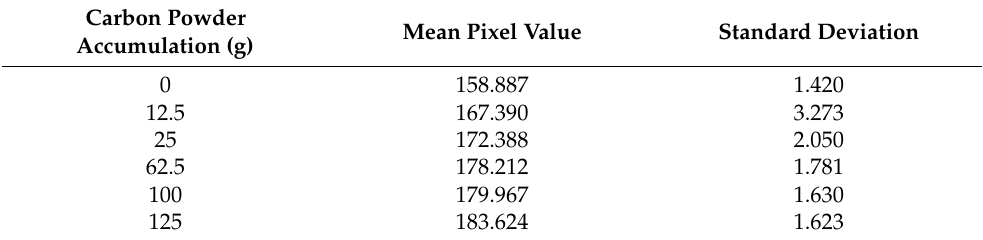
Figure 8. The graph of pixel values according to carbon powder accumulation condition. Table 6. Pixel values according to each accumulation condition (carbon powder).